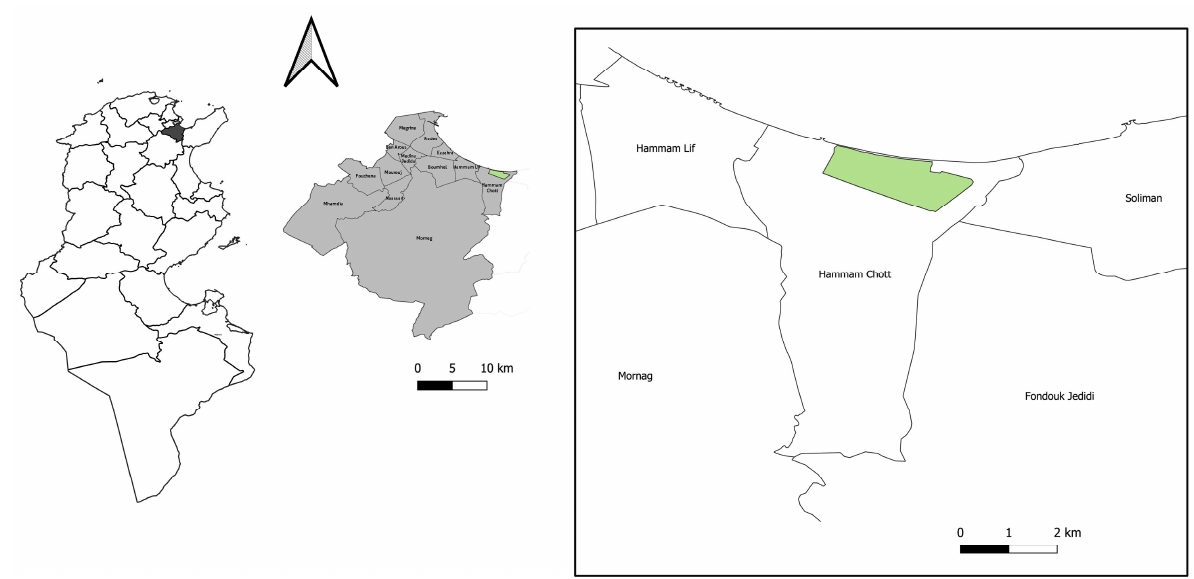
Figure 1. Situation map of Bir El Bey.